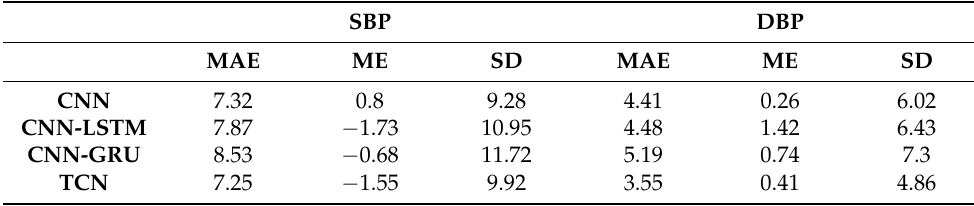
Table 3. Results of each model on the dataset augmented with EEMD.